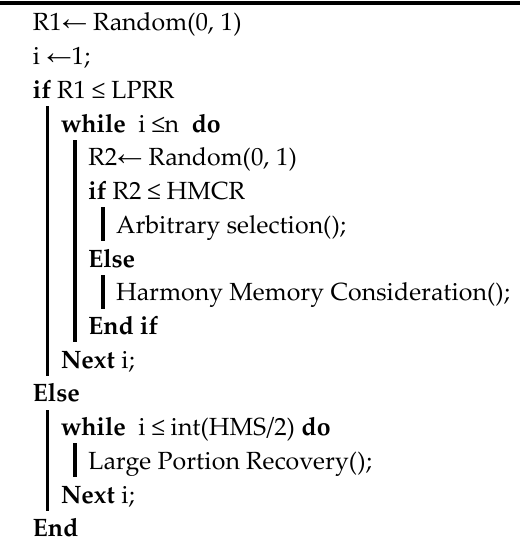
Algorithm 2: Improvisation of new harmony